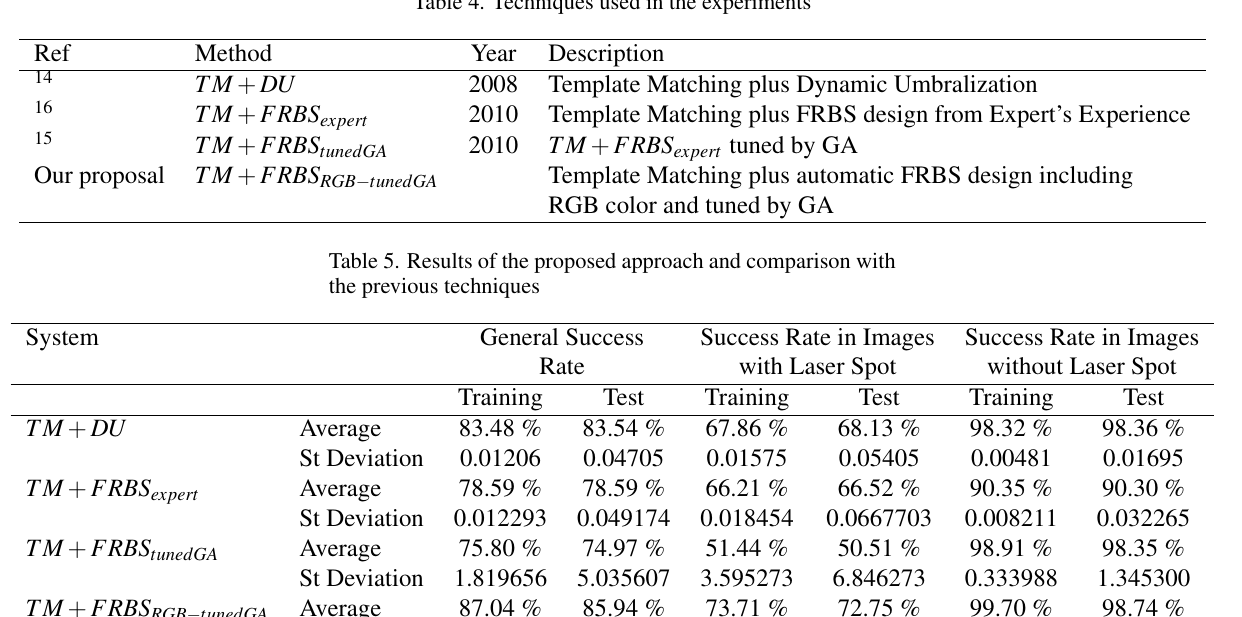
Table 4. Techniques used in the experiments